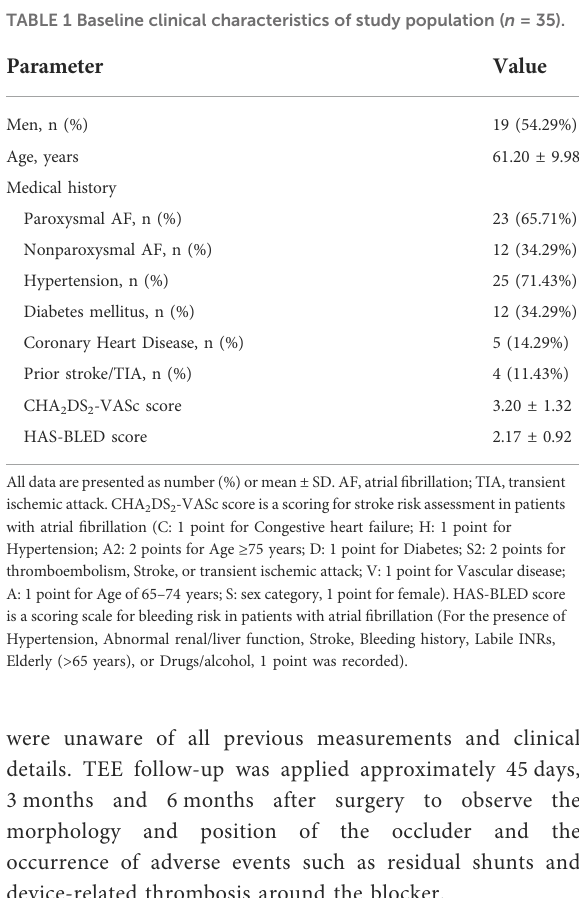
TABLE 1 Baseline clinical characteristics of study population ( n =